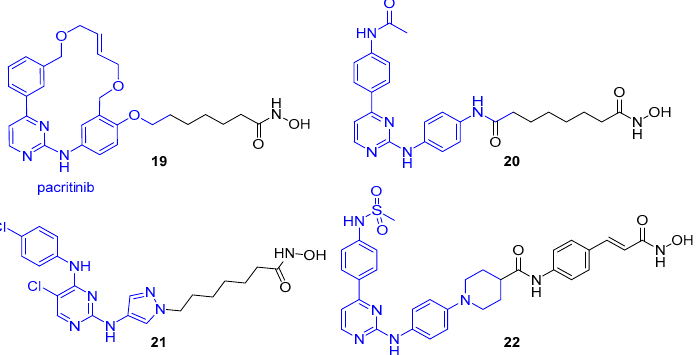
Figure 7. Janus kinases (JAK)-targeting HDAC6-selective dual inhibitors. Components: JAK inhibitor (blue), HDAC inhibitor (black).